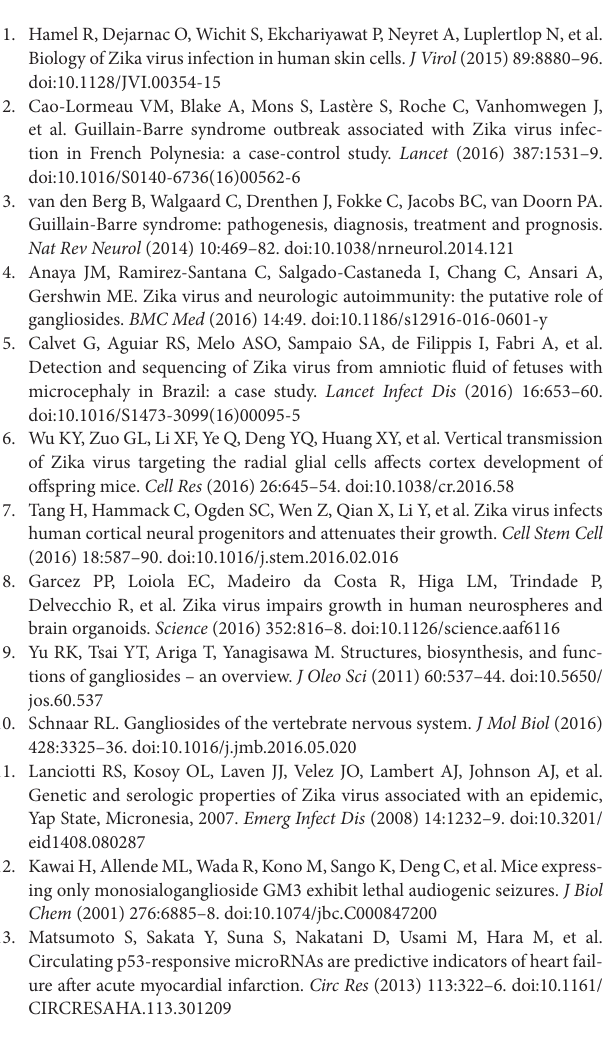
FigUre s3 | Anti-DNA antibody responses in Zika patients and health control individuals. ELISA plates coated with calf thymus DNA were incubated with 1:50 dilution of sera from Zika patients or control healthy individuals. Scatter plot showing individual values for each patient ( n = 7) and normal individuals ( n = 7). Data are mean ± SE and represent the results of three independent experiments. Differences between groups are significant *( p ≤